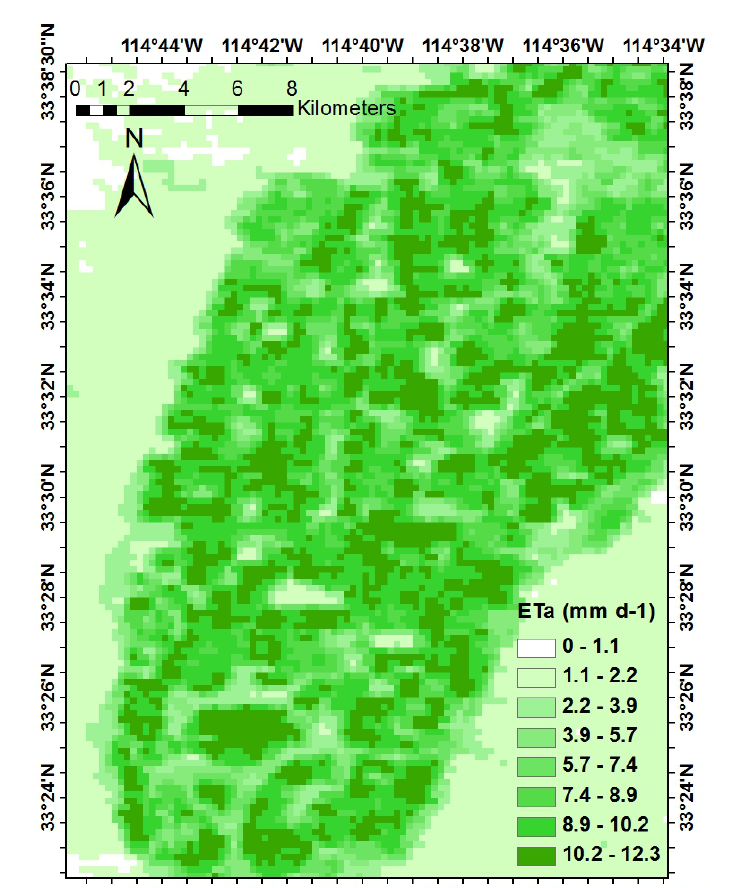
map for the southern portion of the Palo Verde Irrigation District, Figure 6. MODIS ET a CA. Pixel values are the mean for three acquisition dates (26 June–28 July 2007), based on mean ET = 9.8 mm·d − 1 o